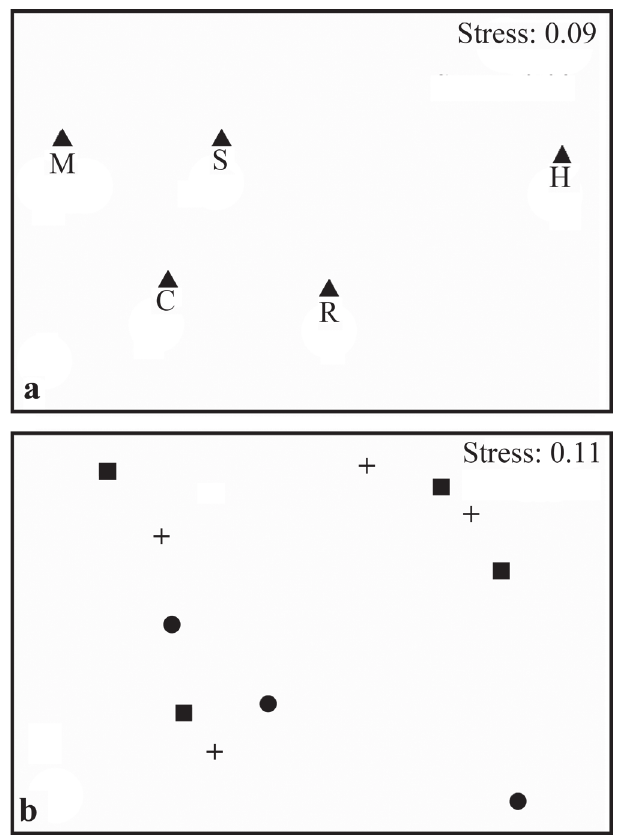
Fig. 3. Non-metric multi-dimensional scaling ordination plot derived from a Bray-Curtis similarity matrix constructed from the fish abundance data (log X + 1 transformation) in different types of habitat ( a ) and climatic seasons ( b ) in the Ría Lagartos system between October 2004 and December 2008. hyperhaline: H, rocky: R, seagrass: S, channel: C, marine: M. %: Rainy, % Northerlies, + Dry.